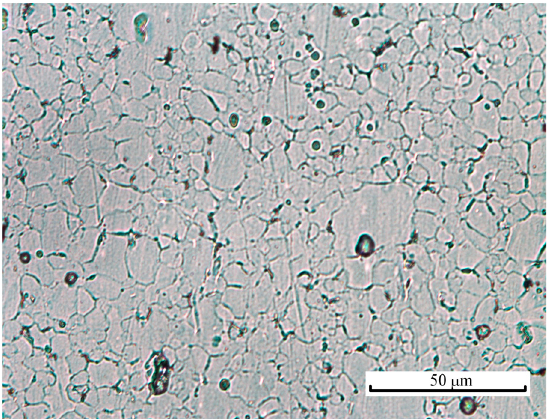
Figure 1. Optical micrograph of the studied AZ31 magnesium alloy to determine the grain size.